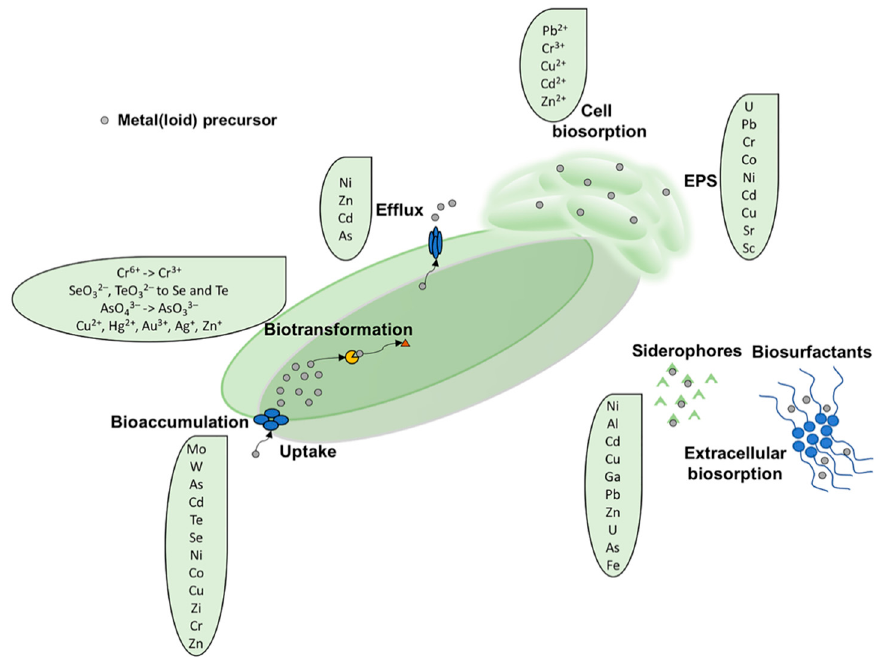
Figure 1. Schematic representation of biotic mechanisms (i.e., biosorption and extracellular sequestration by siderophores, biosurfactants, and extracellular polymeric substances (EPS), bioaccumulation, biotransformation, and metal efflux processes) of interaction between Actinobacteria and metal(loid)s.